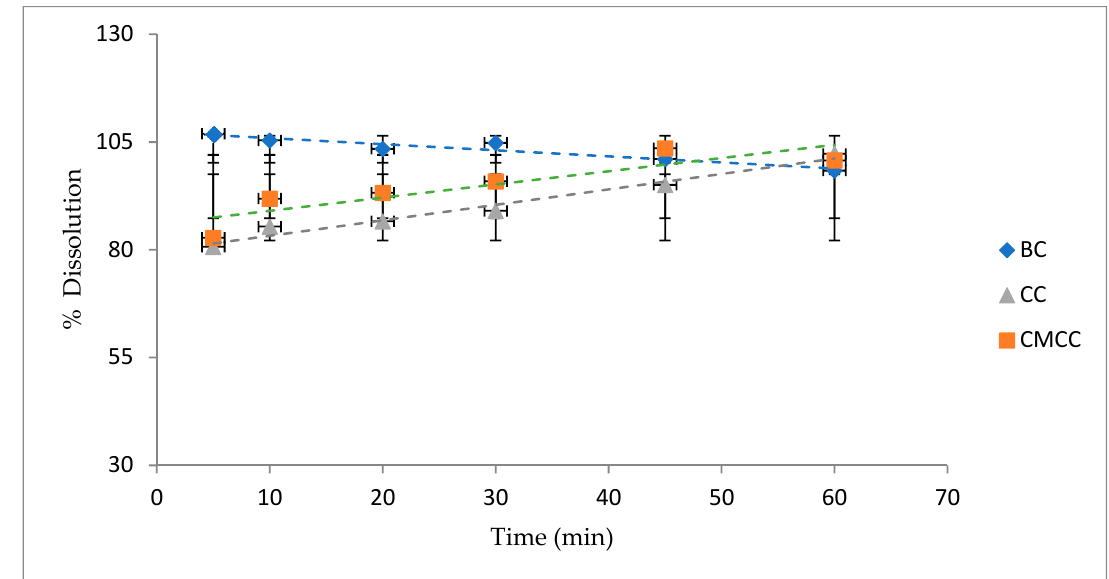
Figure 5. Dissolution profile of acetaminophen from tablets with BC, CC, and CMCC as excipients at 37 °C with 0.05 M monobasic phosphate buffer pH 5.8 as medium.